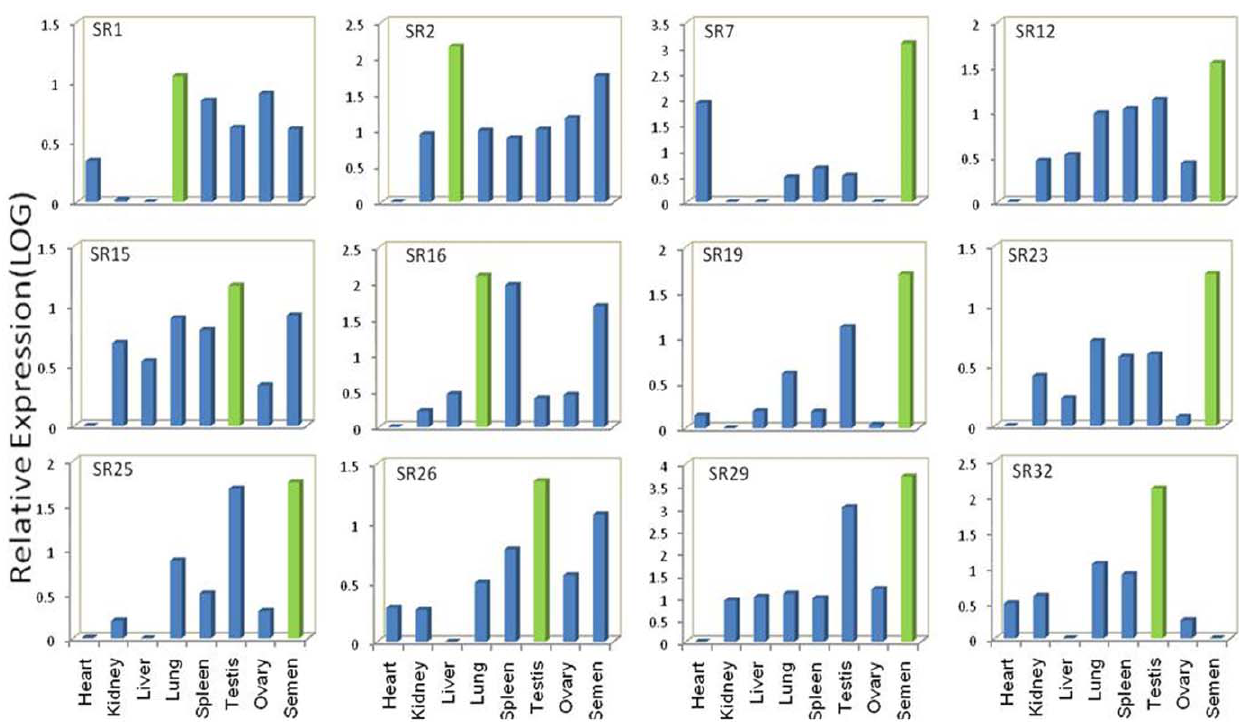
Figure 4. Quantification of mRNA transcripts originating from different tissues. The bar represents the expression level of the transcripts, which are labeled at the top left. The tissue IDs are displayed at the bottom. Maximum expression observed in a tissue is shown in green. To obtain a comparative profile, subsequent q-PCR using internal primers was conducted on all cDNA samples including that from semen. Note the highest expression level of most of the fragments occurs in the testes or spermatozoa.